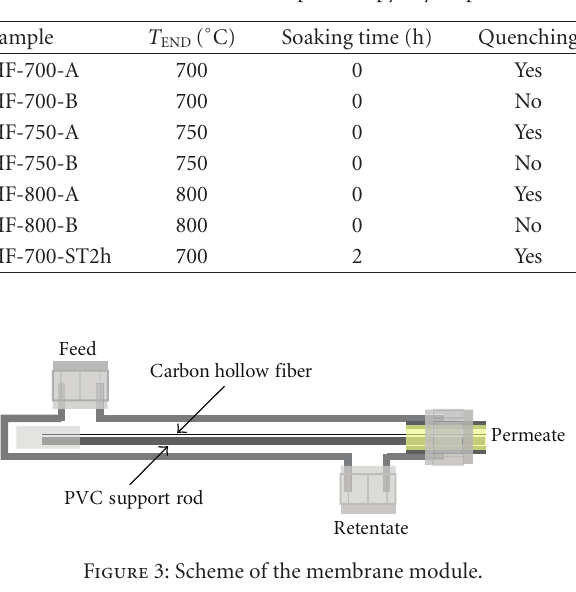
Table 1: Identification of the samples and pyrolysis’ parameters.